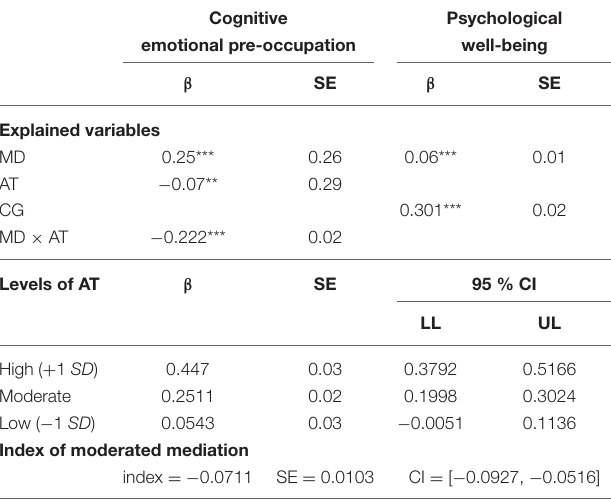
Frontiers in Psychology |